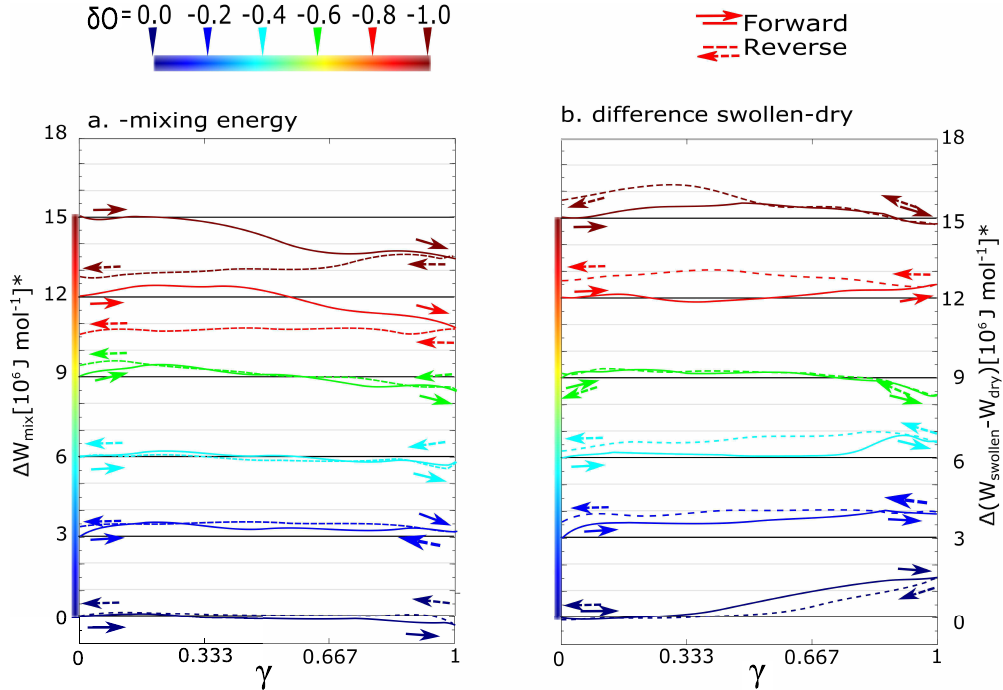
Figure 3. Contribution of solvent during forward-reverse shear deformations; ( a ) the components of mixing energy: The energy of dry network and solvent were separated from the total potential energy of swollen network. The physical meaning is a thermodynamic contribution of mixing energy during deformation; ( b ) mixing as a difference of two simulations: Swollen and dry networks. The physical meaning is the influence of water on the evolution of the